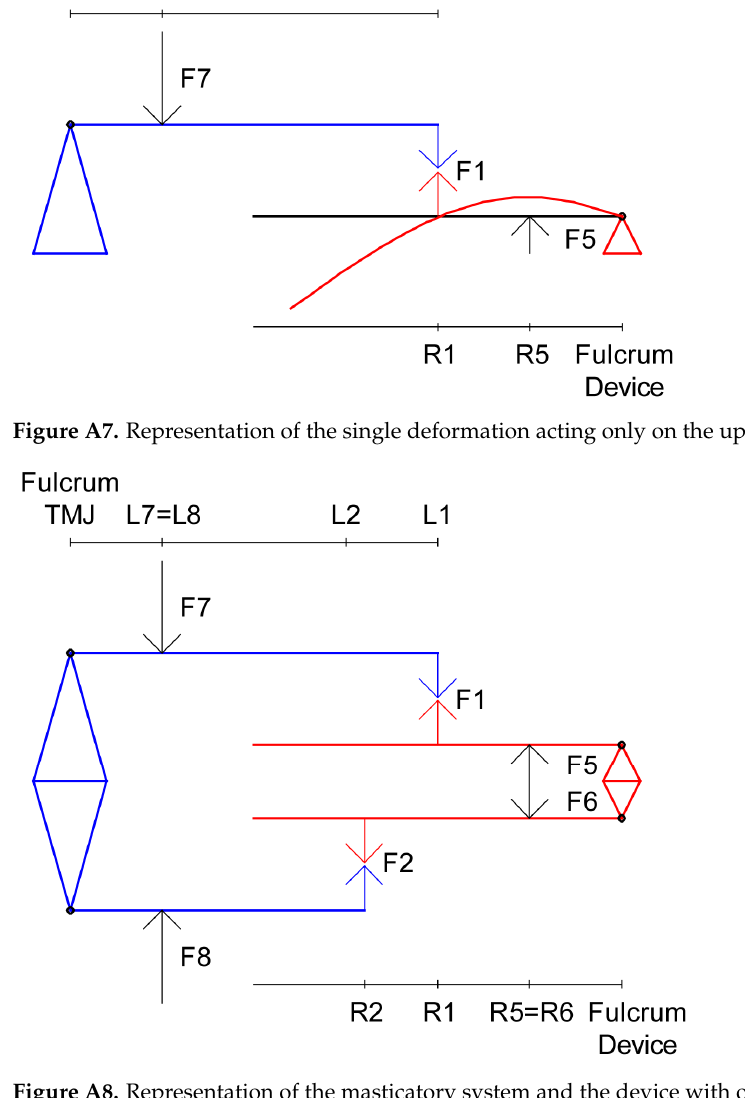
Figure A9. Representation of the masticatory system and the device neglecting internal forces. Since the upper and lower forces are not applied along the same axis, the resultant unbalanced moment would generate a rotation. The direction of this moment will depend on the difference R1 − R2 . However, since the real device does not actually rotate during the task, other constraints would compensate for the resultant moment. Therefore, the contact points R3 and R4 can be reconsidered as applied points for constraint forces, which balance that moment. Whether R1 < R2 , the moment would have a clockwise direction and negative sign, which will unload on R3 (Figure A10).